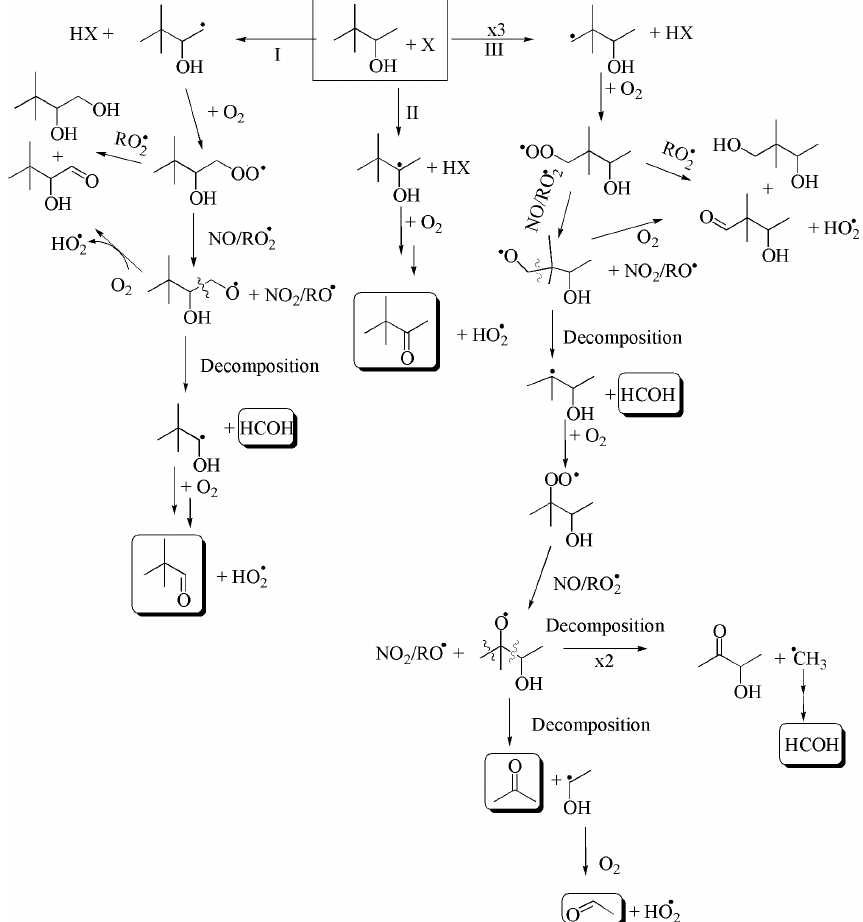
Figure 8. Reaction mechanism for the degradation of 3,3DM2ButOH with X (the Cl atom and the OH and NO 3 radicals). The mechanism for the formation of carbonyl compounds. Compounds marked with a solid line are positively identified. Compounds marked with a dotted line are not positively